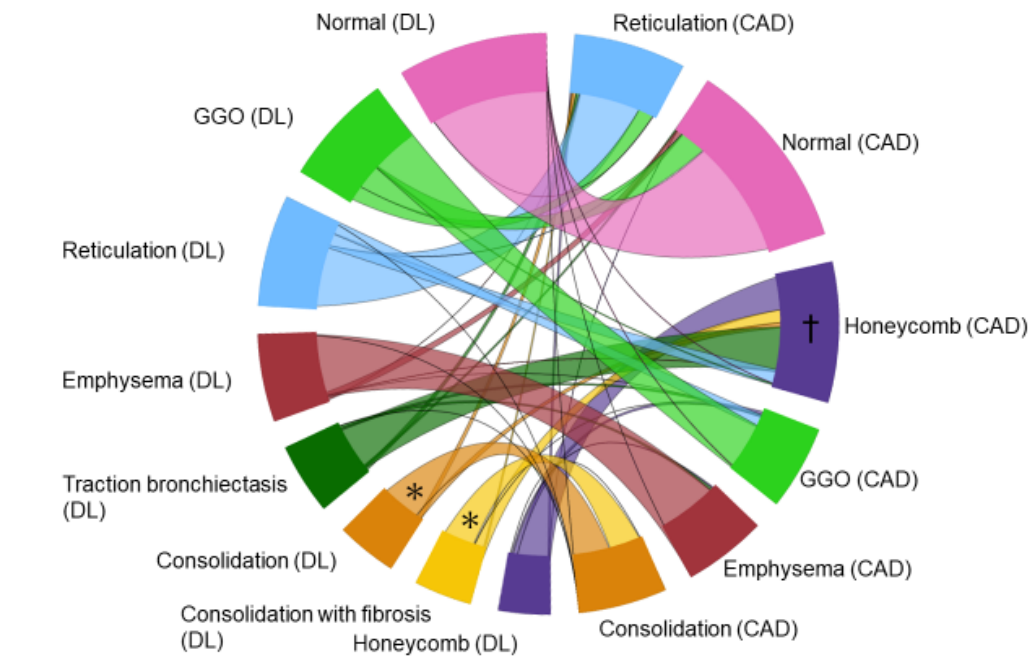
Figure 6. Chord diagram comparing the CAD and DL-based method outputs. The color of the chord is set to match the DL-based analysis. Most pixels that the CAD system interpreted as consolidation, the DL-based method divided into consolidation with and without fibrosis (asterisk). Most pixels that the CAD system interpreted as honeycombing (dagger), the DL-based method divided into honeycombing, traction bronchiectasis, reticulation, and consolidation with fibrosis.